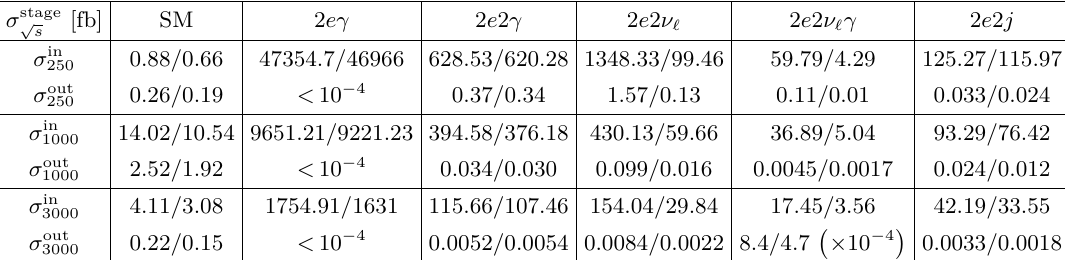
√ s = { 250 , 1000 , 3000 } GeV. √ , P for each s , reported as left/right e + e − √ s = 250 GeV, the kinematic phase